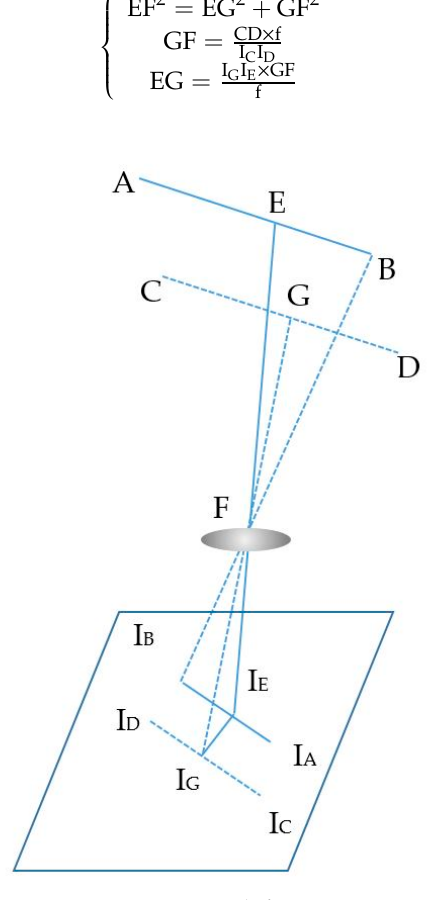
Figure 6. Center shift scenario.